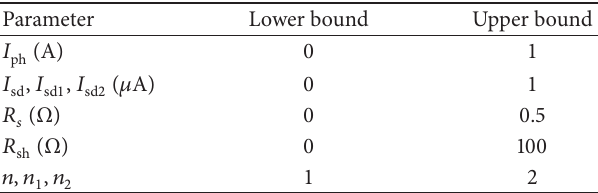
Table 7: The search spaces for a single diode model and double diode model.